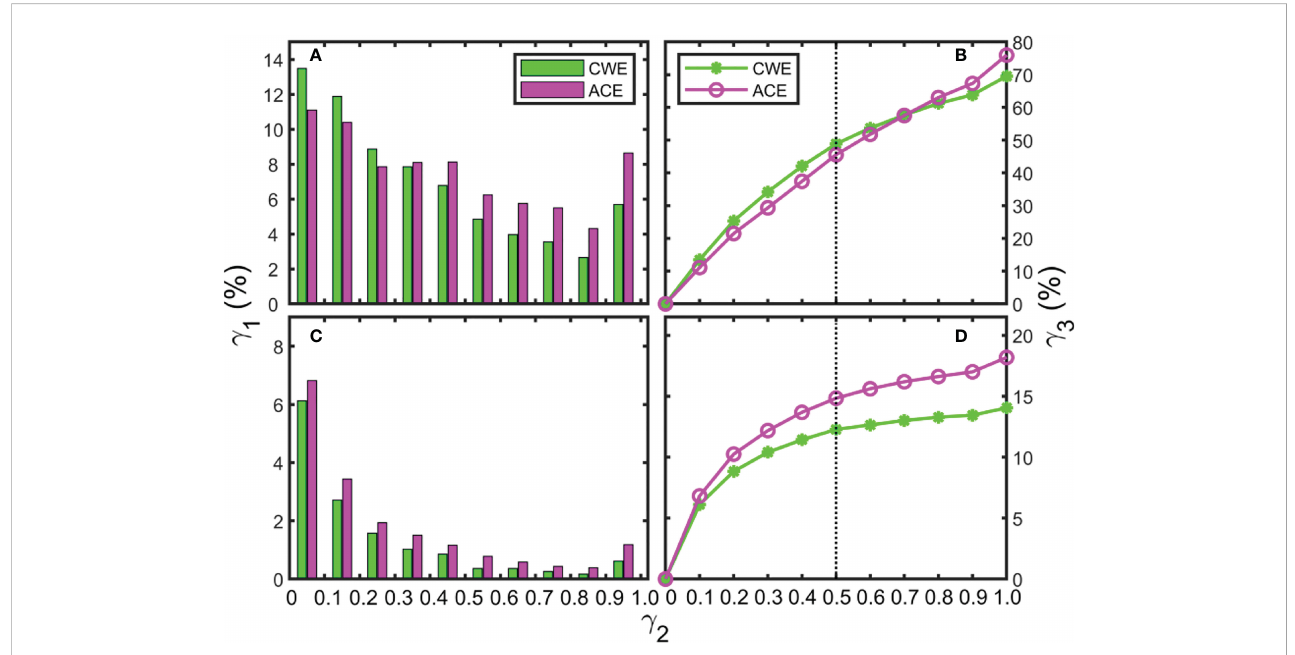
FIGURE 9 Statistical histogram of the anomaly ratio, which is the time length during which an eddy is abnormal to the overall eddy lifespan (A, C) , and the corresponding cumulative frequency (B, D) at the sea surface layer (A, B) and 1,000 m (C, D) in the STCC area. Green and magenta indicate cyclonic cold-core eddy and anticyclonic warm-core eddy,